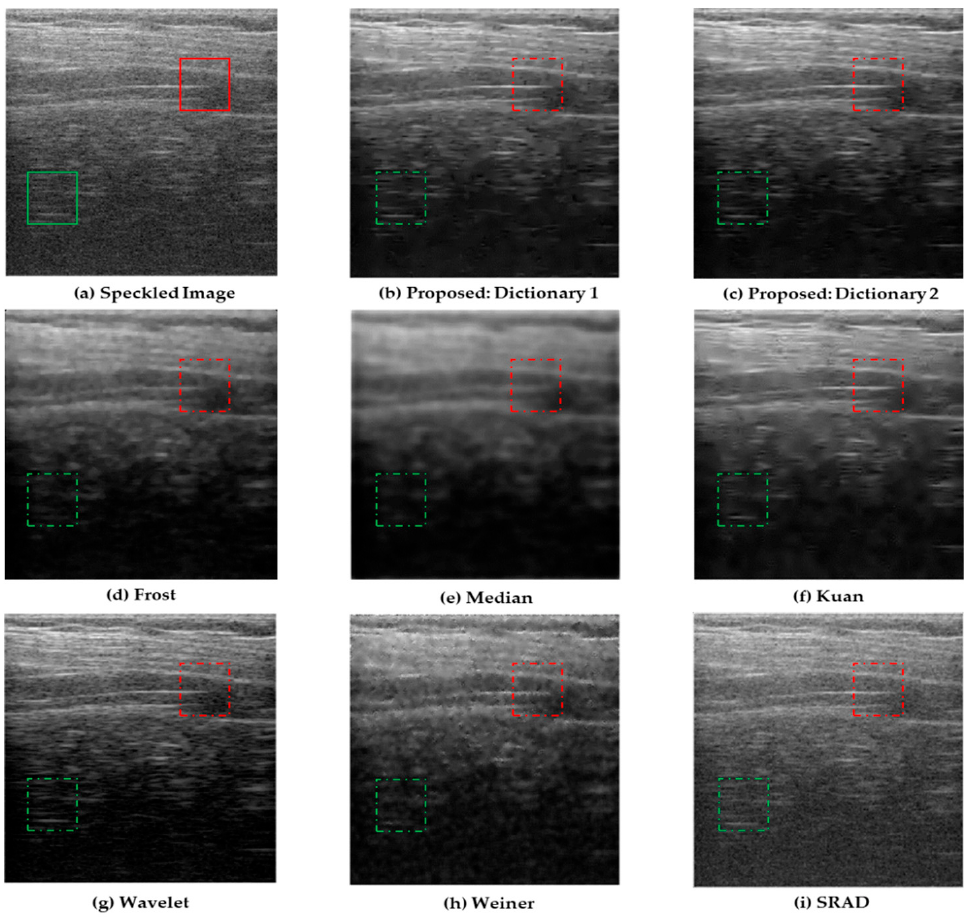
Figure 7. Despeckled results obtained for the ultrasound liver dataset using a linear transducer with a frequency of 8 MHz. The red and the green boxes highlight the differences observed from the noisy and filtered images. ( a ) Speckled image and results yielded by the proposed method using ( b ) Dictionary 1 and ( c ) Dictionary 2 as well as results using the ( d ) Frost; ( e ) median; ( f ) Kuan; ( g ) wavelet; ( h ) Weiner; and ( i ) SRAD filters.